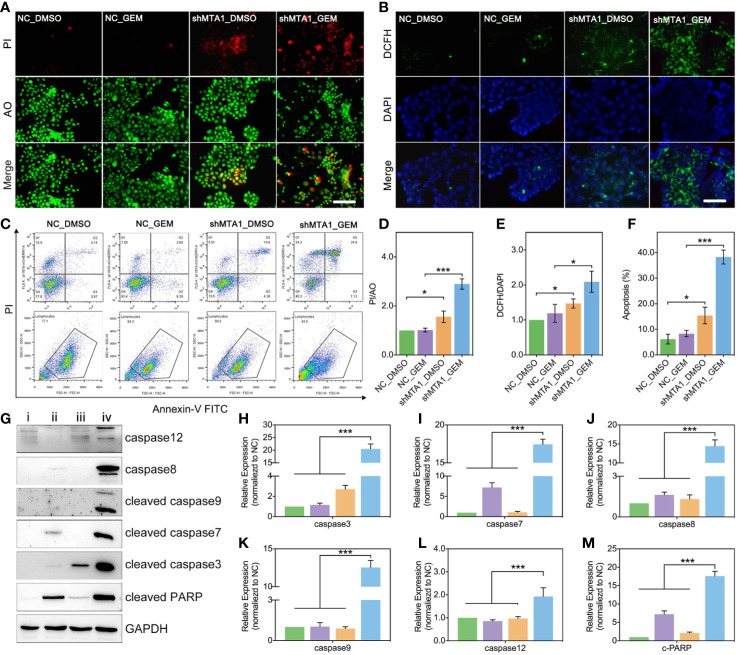
MTA1 knockdown with gemcitabine treatment up regulated the ros-reaction and apoptosis in MCF-7 cells. (1) breast cancer cells (NC_MCF-7 or shMTA1_MCF-7) are planted in 24-well plates for 24h, followed by 48h-treatment of 5μM gemcitabine or DMSO (4 groups: NC_DMSO, NC_GEM, shMTA1_DMSO and shMTA1_GEM), which are tested for live-death assay (live: green, death: red) (A, D). (2) breast cancer cells (MCF-7 or shMTA1_MCF-7) are planted in 24-well plates for 24h, followed by 48h-treatment of 5μM gemcitabine or DMSO (4 groups: NC_DMSO, NC_GEM, shMTA1_DMSO and shMTA1_GEM), which are tested for ros-reaction through ros probes (ros: green, DAPI: blue) (B, E). (3) breast cancer cells (MCF-7 or shMTA1_MCF-7) are planted in 6-well plates for 24h, followed by 48h-treatment of 5μM gemcitabine or DMSO (i: NC_DMSO, ii: NC_GEM, iii: shMTA1_DMSO, iv: shMTA1_ GEM), which are tested for apoptosis and WB assay (C, F–M).